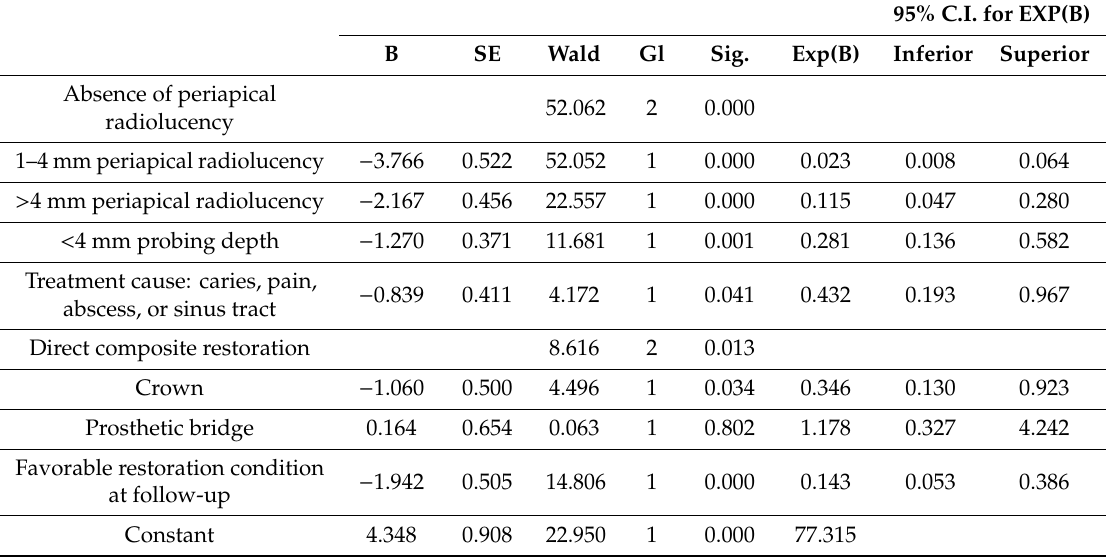
Table 4. Logistic regression